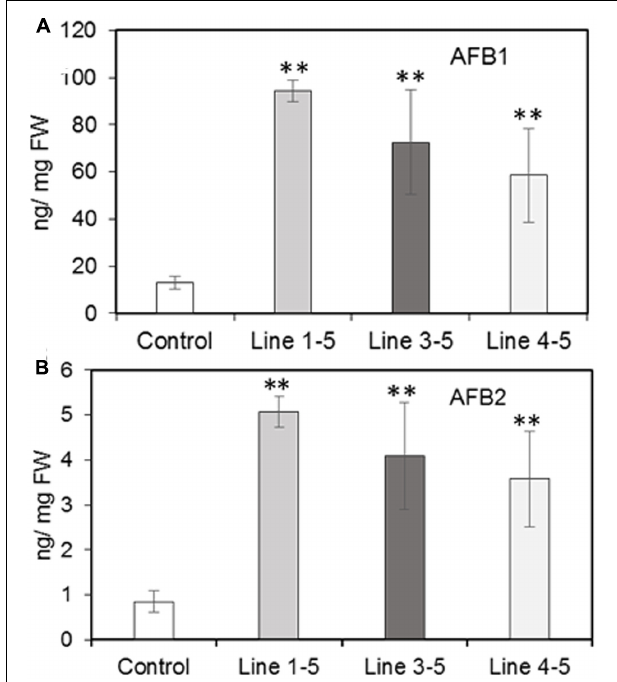
FIGURE 4 | Aflatoxin (AF) contents in the control (empty vector transformed) and ZmPRms– RNAi transgenic maize kernels at 7 days post inoculation (dpi) with A. flavus . (A) AFB1; and (B) AFB2. Data are mean ± SE of 4 biological replicates. ∗∗ Denotes significant difference between control and PRms silenced lines ( P ≤